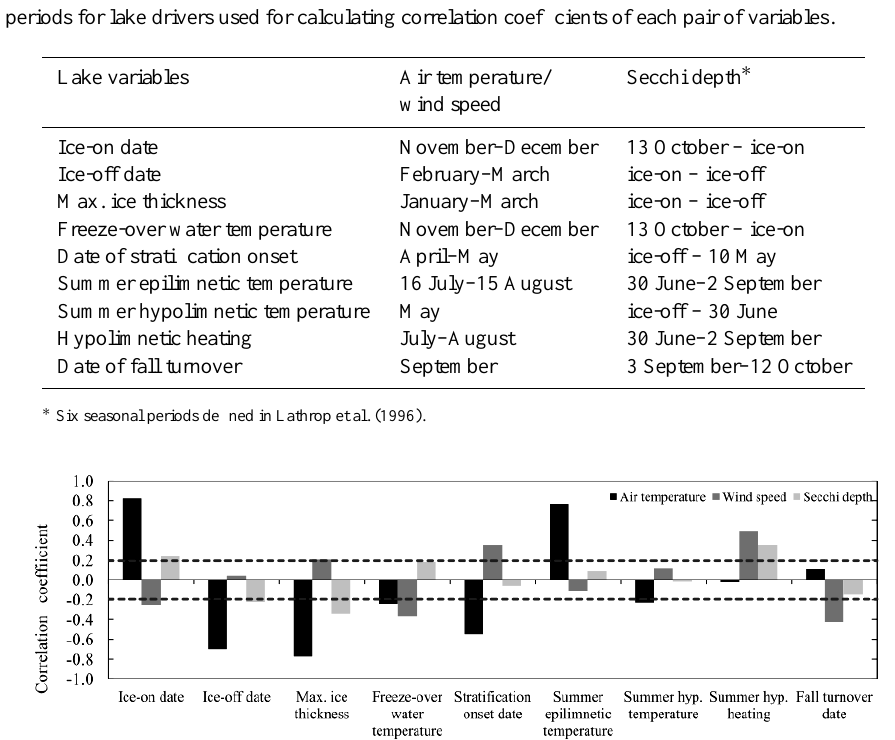
Figure 12. Correlation coefficients between lake variables and drivers. The critical value (dashed lines) for significant correlation ( p < 0.05) is 0.193 ( n =